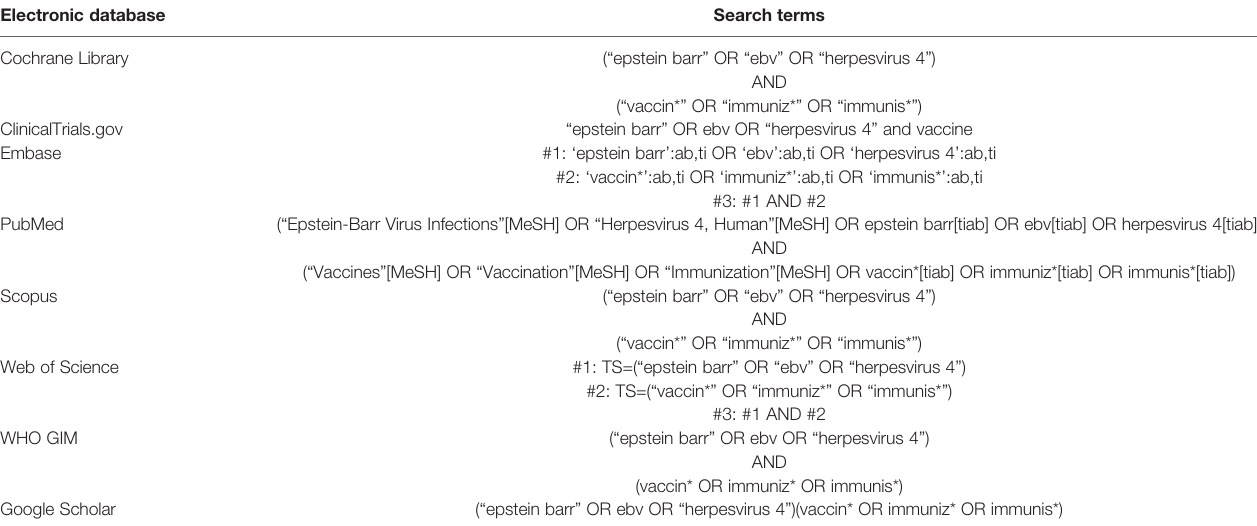
TABLE 2 | Electronic database